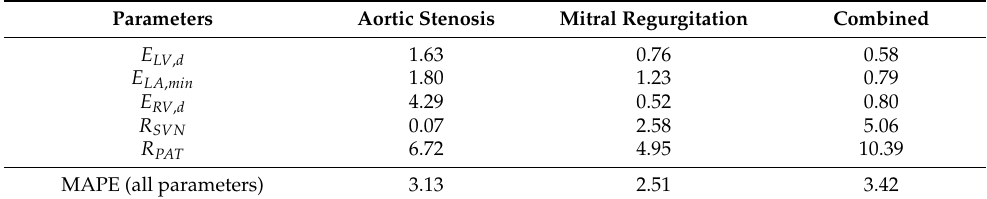
Table 9. Absolute percentage errors (APEs—Equation (30)) per parameter for datasets generated using increased pulmonary arterial resistance with aortic stenosis, mitral regurgitation, and both valvular diseases